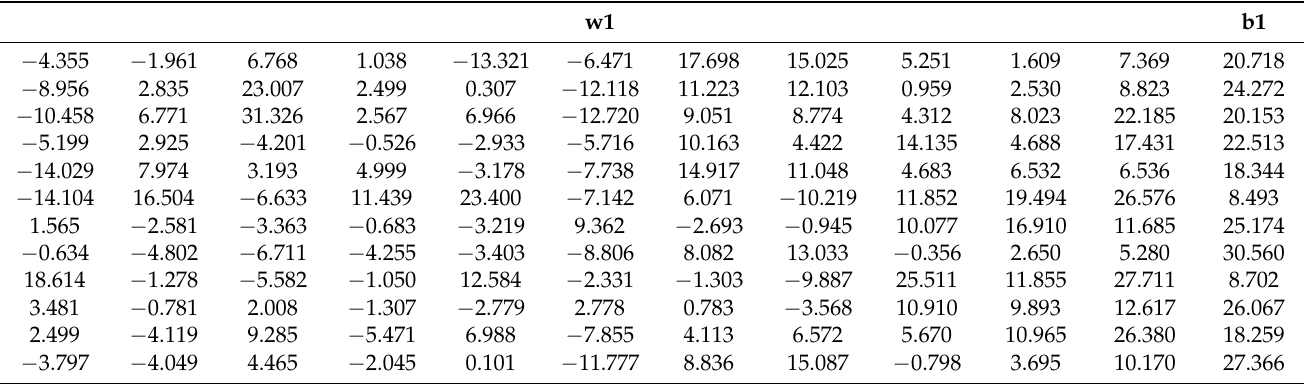
Table 6. The weights and bias from the hidden layer to the output